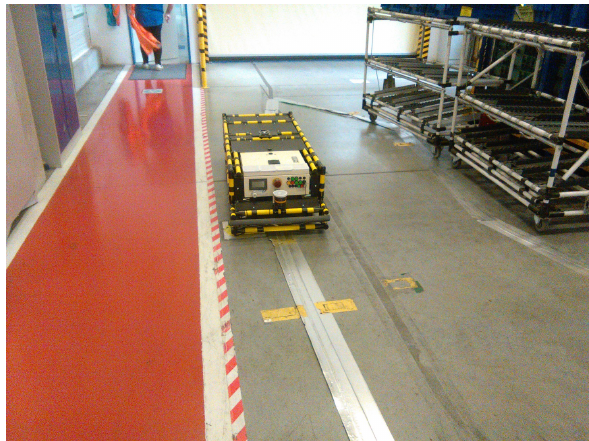
Figure 1: The automated guided unmanned vehicle using magnetic tapes.